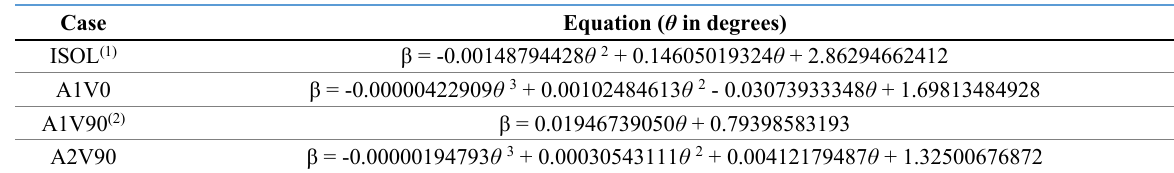
Table 8. Equations of β for acceleration at the top, y-direction – limit criterion of 8.4 cm/s 2